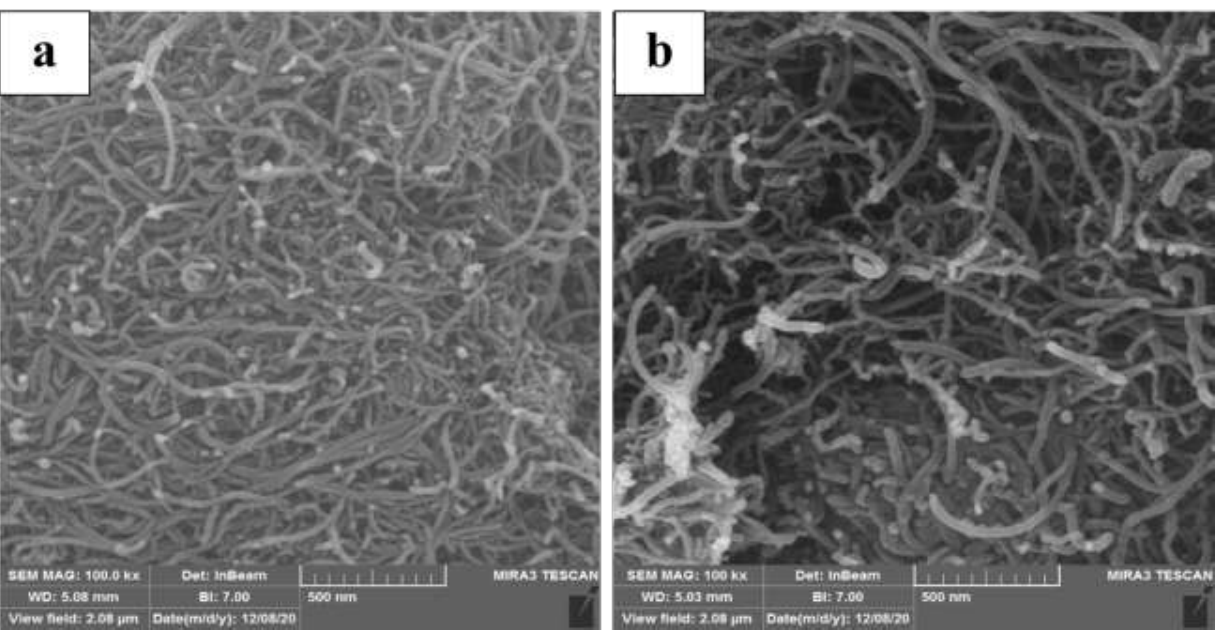
Figure 3: FESEM images of a) R-MWCNTs and b)